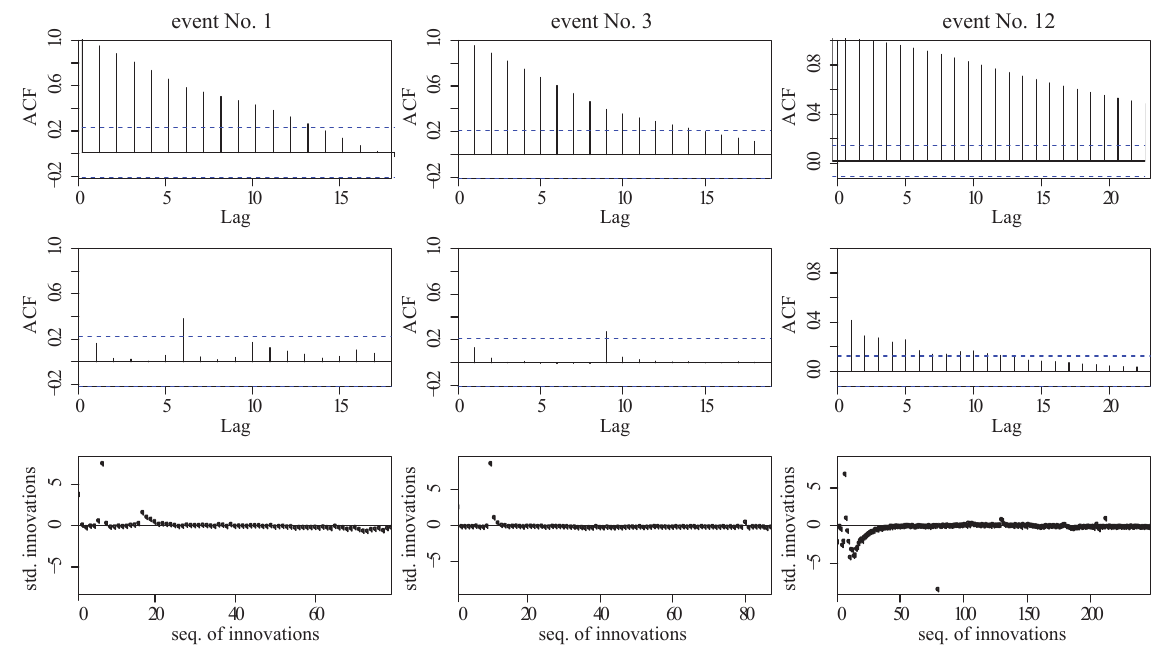
Fig. 4. Diagnostic plot of residuals and innovations. Autocorrelation function (ACF) of standardized residuals (top row), ACF of standardized innovations (middle), and sequences of innovations (bottom).